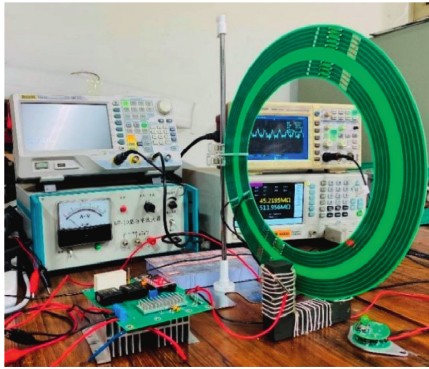
Figure 9: Experimental platform of the U-type coupling mechanism wireless power transfer system.